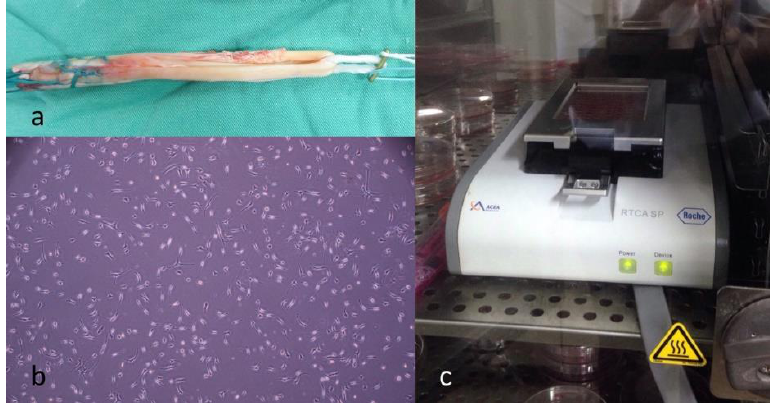
Figure 1. Harvest human hamstring tenocytes. ( a ) Tenocytes were isolated from hamstring tendon during anterior cruciate ligament (ACL) reconstruction. ( b ) Cell seeding in culture medium. ( c ) An xCelligence system was used for real-time tenocytes proliferation monitoring.